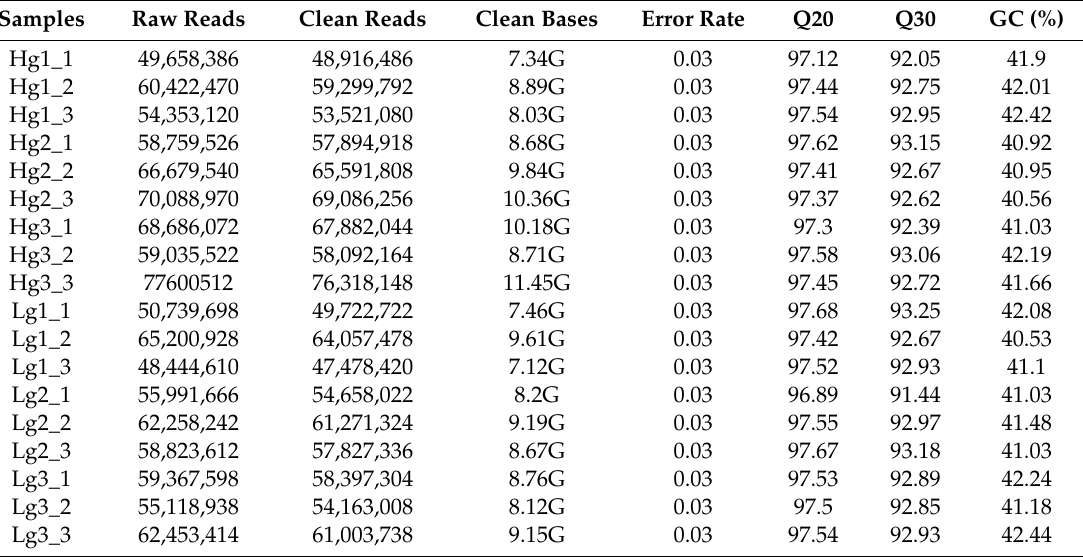
Table 1. Summary of RNA-seq quality data of 18 B. pyrosoma